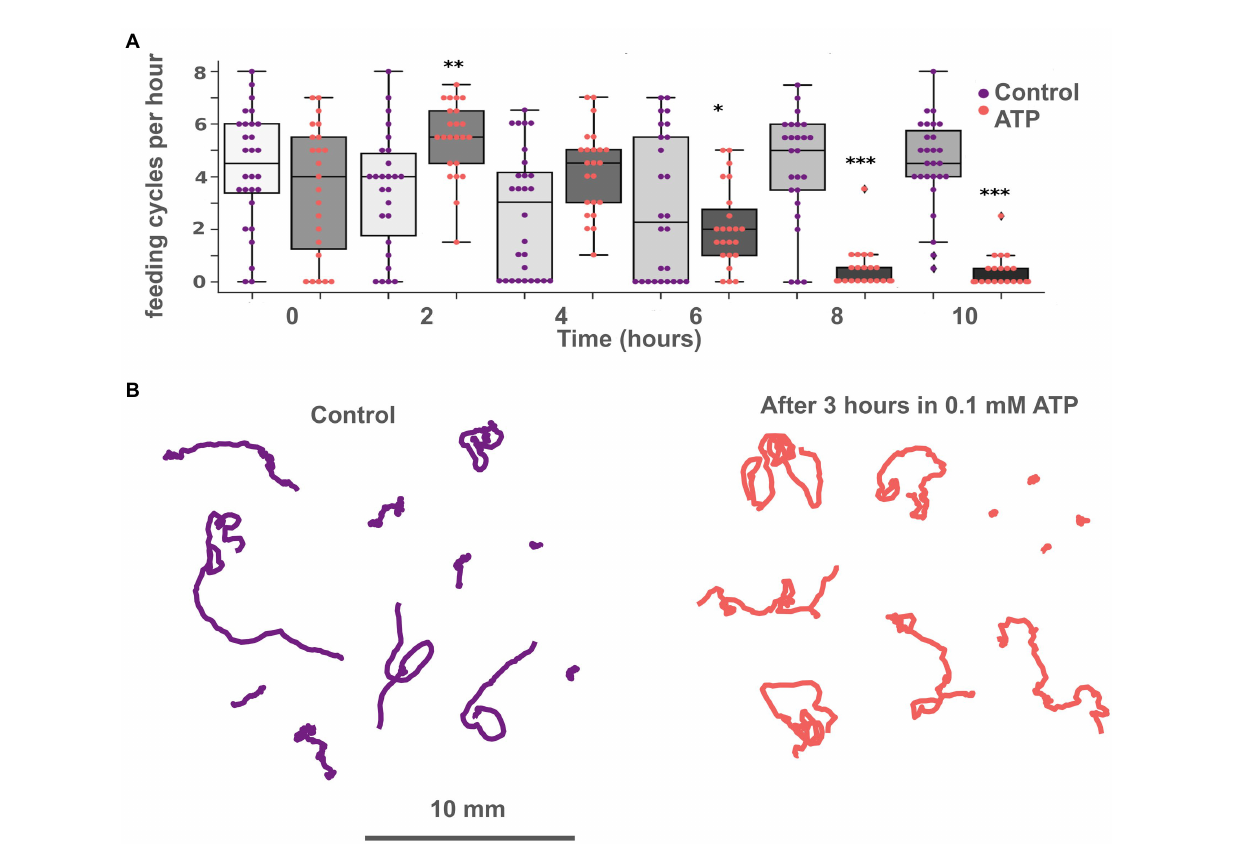
FIGURE 5 ATP exhibits long-term suppression of feeding and does not affect locomotion. (A) Bar chart of feeding activity of Trichoplax on green algae biofilms in normal conditions and with 0.1 mM ATP. Adding ATP to the dish with green algae increases ‘feeding’ activity at first and decreases after 6 h. In the experimental dish, ATP was added at 2 h. Asterisks denote a significant difference in feeding activity from the control (Welch t -test, * p < 0.05, ** p < 0.01, *** p < 0.001). N animals = 37 and 28 for ATP and control, respectively. (B) Tracks of animals incubated in 0.1 mM ATP for 3 h (right) and in control (left). No significant differences in track length, straightness, or displacement were